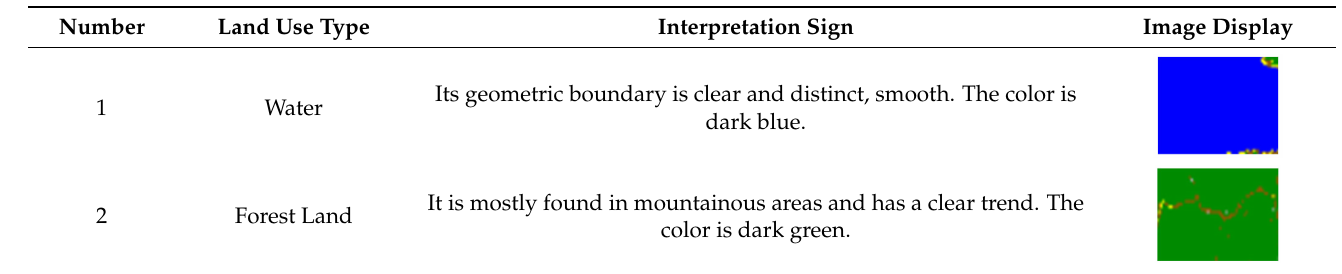
Table 1. Land use type interpretation signs in the buffer